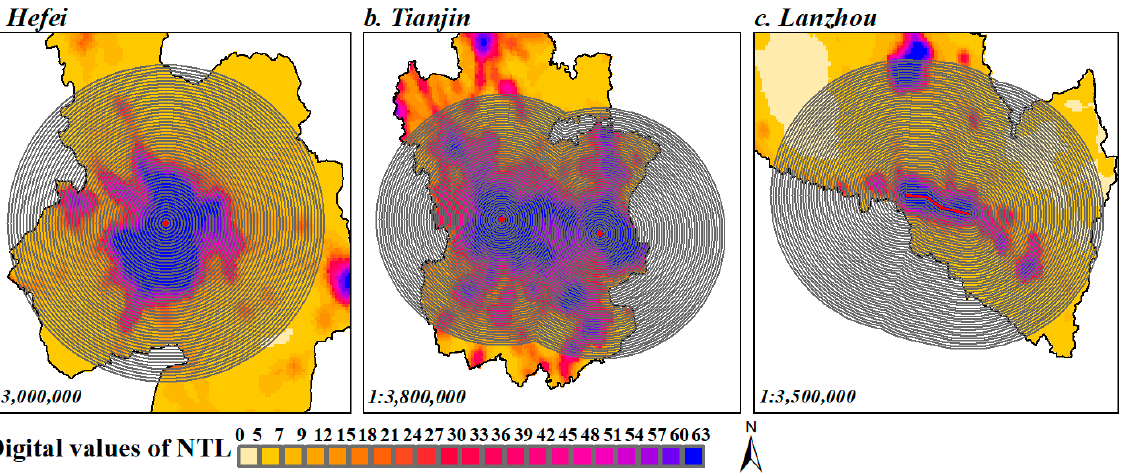
Figure 3. Illustration of urban centers (axes) and concentric rings in monocentric cities ( a ), nonlinear polycentric cities ( b ), and cities with ribbon-shaped growth ( c ).